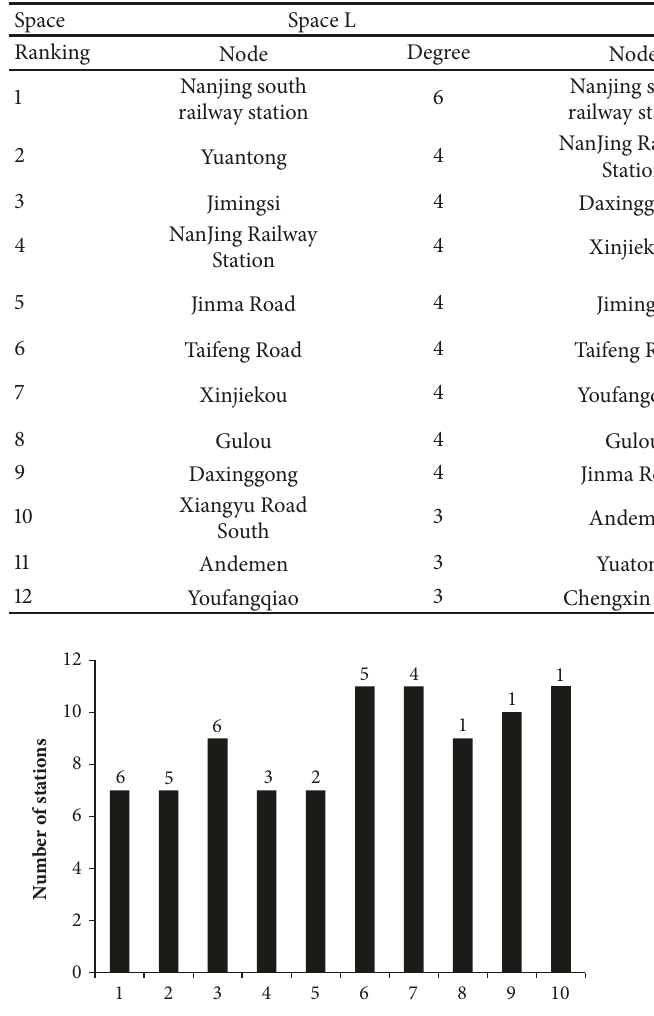
Table 1: Degree distribution of main sites in Nanjing metro.